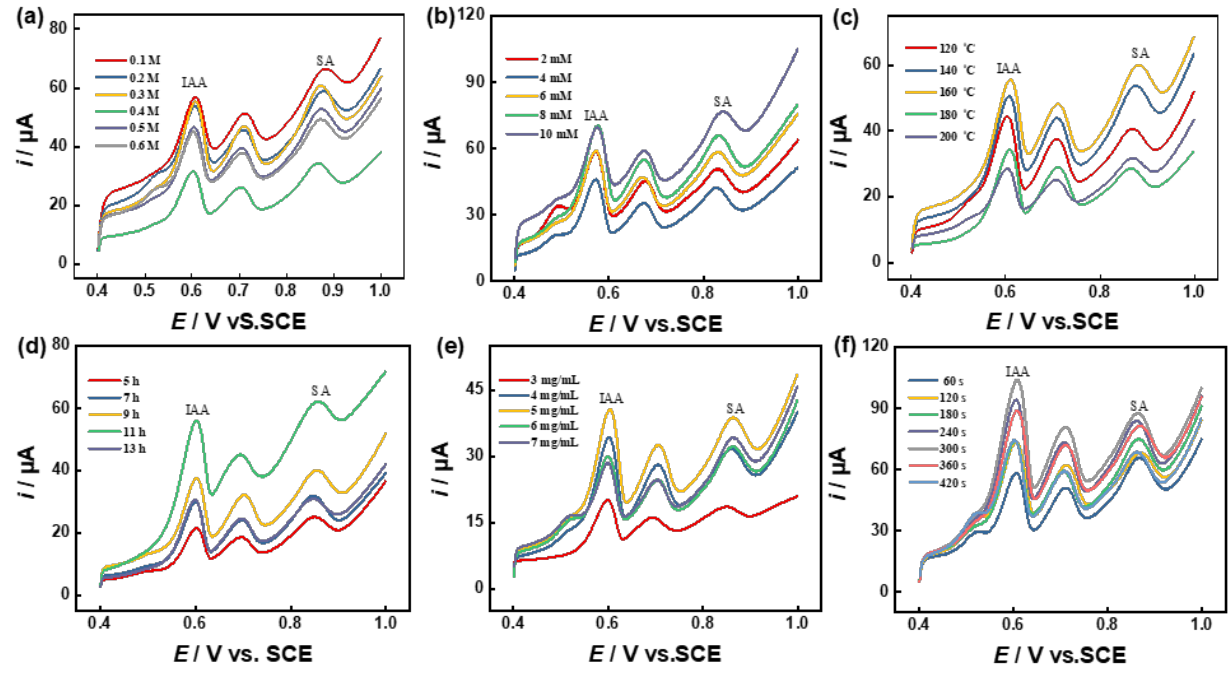
Figure 9. Effects of concentration of Pro ( a ) and HAuCl 4 ( b ), hydrothermal temperature ( c ), hydro- thermal time ( d ), quantity of the composite ( e ), and preconcentration time ( f ) on LSV peak current of PPRONPs − CDs − MWCNTs/GCE in 0.1 M PBS (pH = 7) containing 50 μM IAA and 50 μM SA.